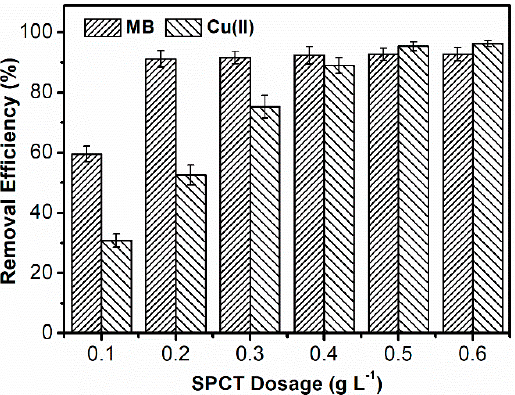
Figure 5. Effect of SPCT dosage on the adsorption of MB and Cu(II).